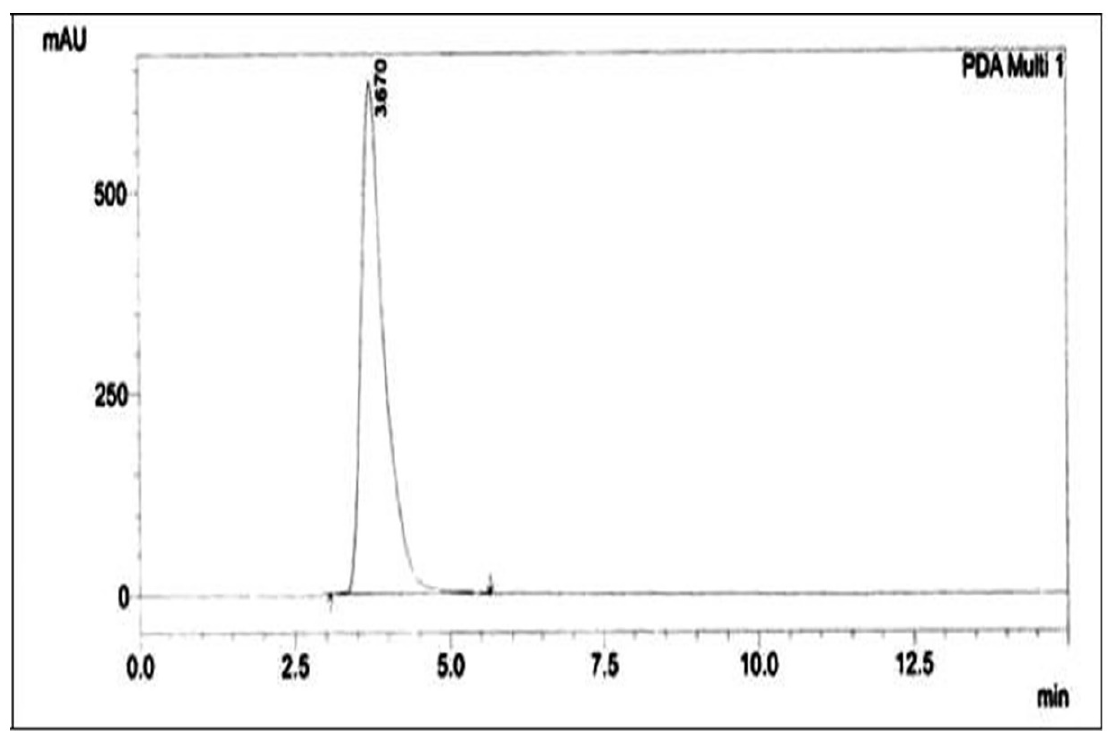
Figure 4. HPLC chromatogram of the purified compound from the extracts of Leucas indica flowers. UV spectroscopy showed characteristic absorption maxima at 270 nm corresponding to π – π * transition, indicating the presence of C=C double bonds in the HPLC-purified compound (Figure 5).